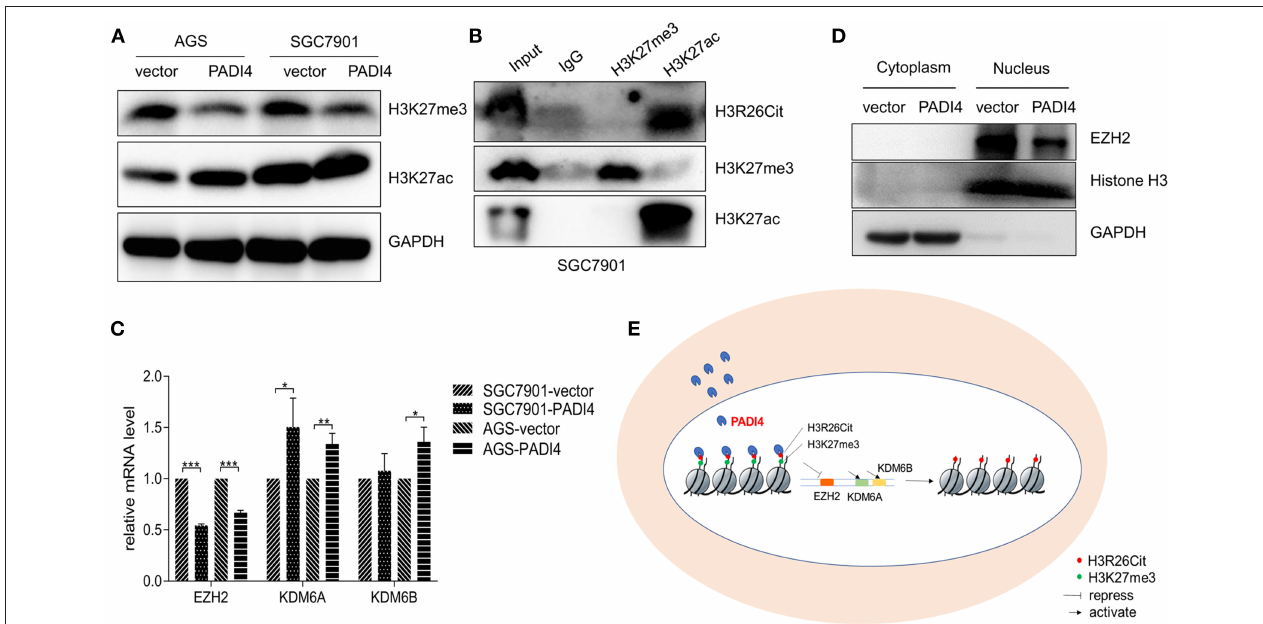
FIGURE 4 | Interaction assay of H3R26Cit and other post-translational modifications. (A) An increase in the level of H3K27ac protein and decreased H3K27me3 protein level were observed in both AGS and SGC7901 gastric cancer cell lines in which PADI4 was overexpressed. (B) Immunoprecipitation was performed by H3K27me3 and H3K27ac antibodies. H3R26Cit was not detected in the H3K27me3 pull-down product, but was found in the H3K27ac pull-down product. (C) Effect of PADI4 overexpression on mRNA expression of the H3K27 methyltransferase EZH2 and demethylases, KDM6A and KDM6B (*, **, and *** represent P < 0.05, P < 0.01, and P < 0.001, respectively) (D) EZH2 expression assay revealed that the protein was located in nucleus, and its expression level was decreased after PADI4 overexpression, with histone 3 and GAPDH serving as internal controls. (E) Schematic diagram of influences on histone modifications of H3R26Cit and H3K27me3 after PADI4